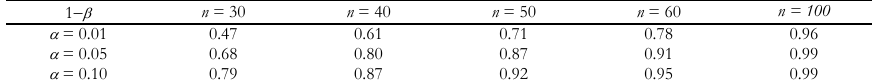
Power 1 − β of the UMP scale invariant